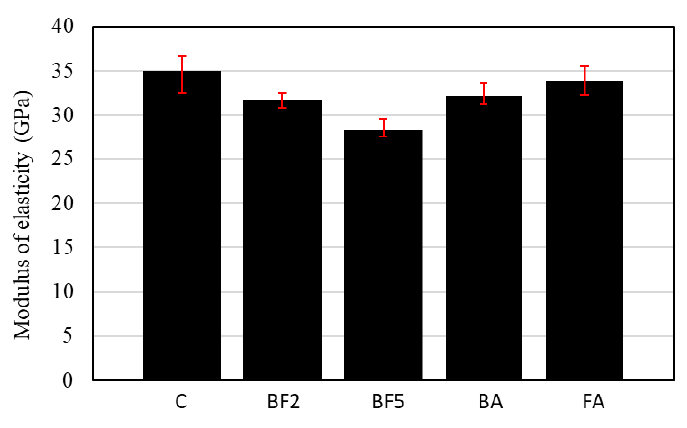
Figure 11. Modulus of elasticity of each mixture.